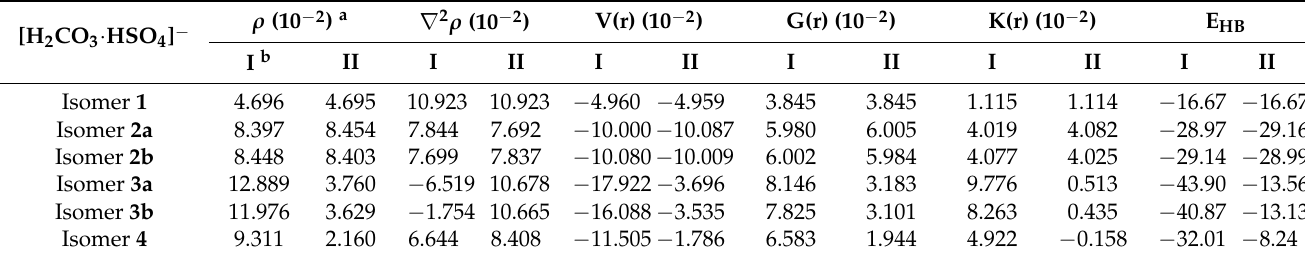
Table 1. Electron density ( ρ ), Laplacian ( ∇ 2 ρ ), potential energy density (V(r)), gradient kinetic energy density (G(r)), and electronic energy density (K(r)) at BCPs of the hydrogen bonds in the different isomeric structures of [H 2 CO 3 · HSO 4 ] − . All units are in a.u, except that E HB is in kcal/mol.